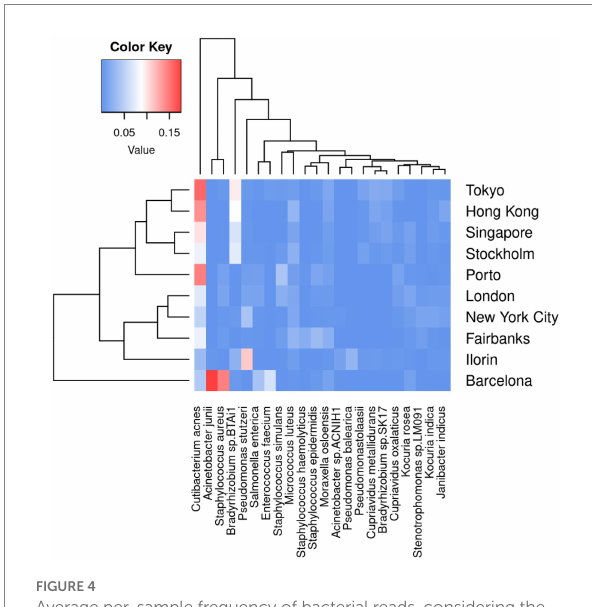
FIGURE 4 Average per-sample frequency of bacterial reads, considering the top 10 cities per number of sample, and the top-5 species per city. The color key represents the prevalence in [0, 1] scale of each species.